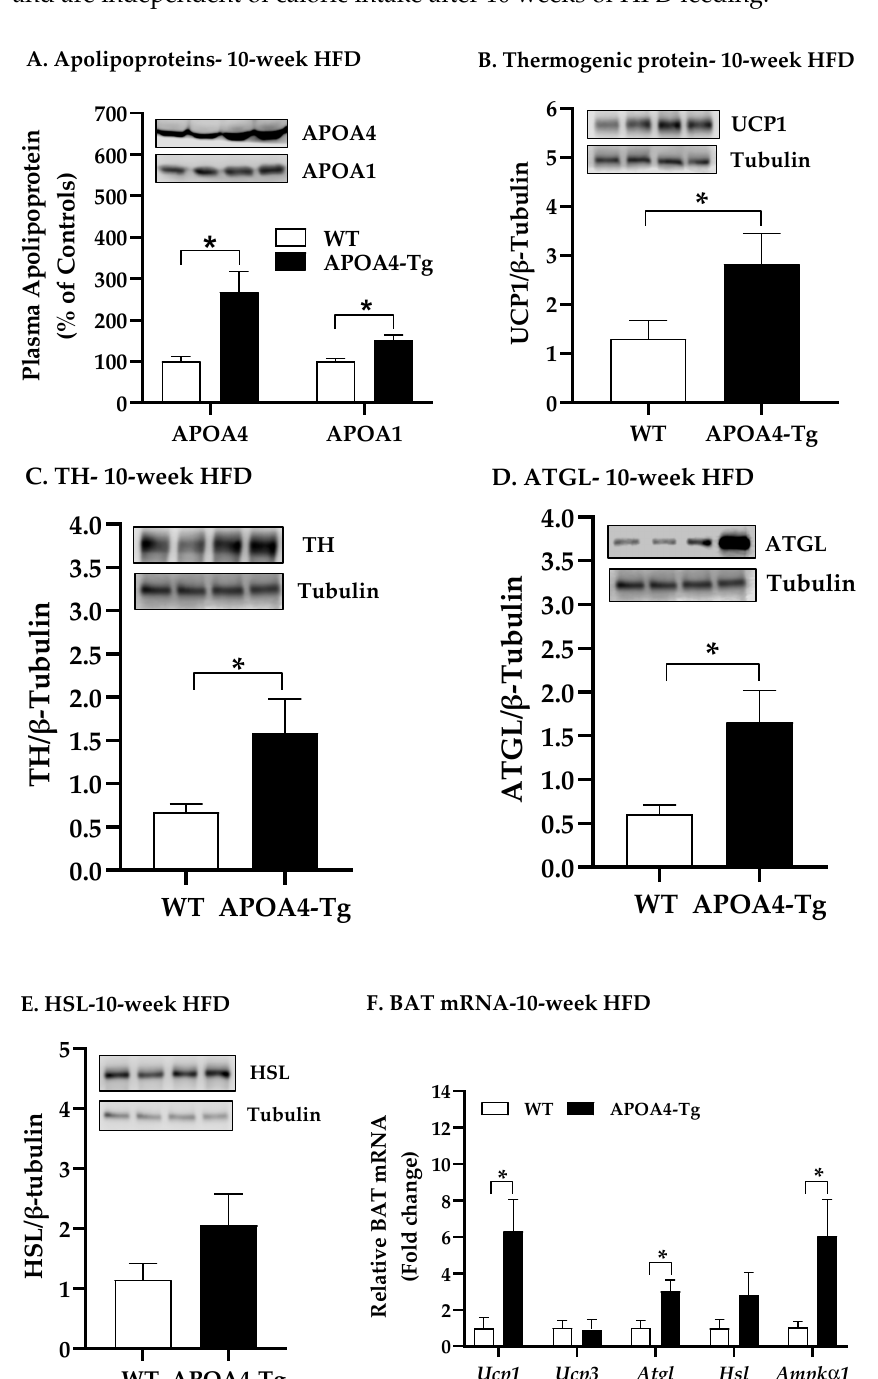
and are independent of caloric intake after 10 weeks of HFD feeding.